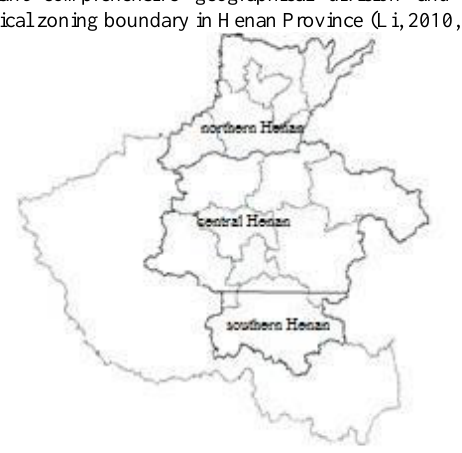
Figure 1. The division of main wheat planted areas in Henan